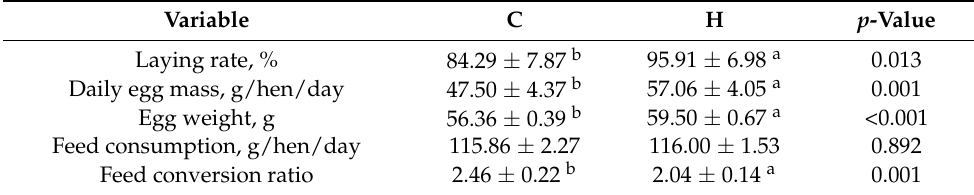
Table 4. The results of layer production indices in week 29 (means ±